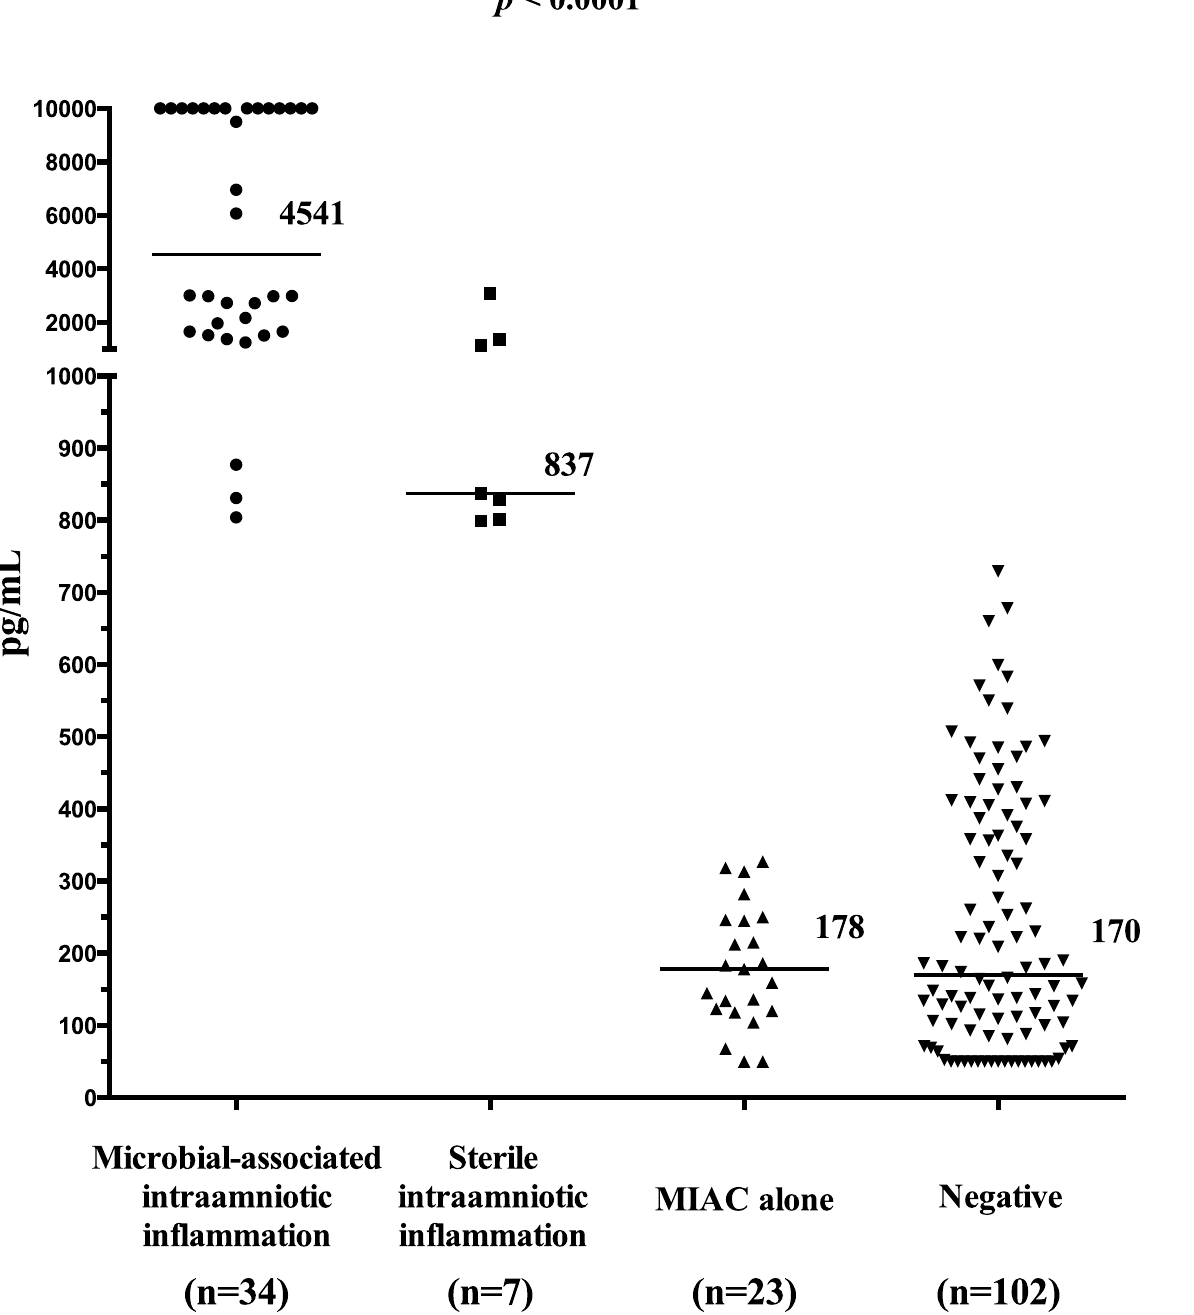
Fig 2. Amniotic fluid interleukin-6 concentrations in preterm prelabor rupture of membrane pregnancies that are complicated with the presence or absence of microbial-associated intraamniotic inflammation, sterile intraamniotic inflammation and microbial invasion of the amniotic cavity